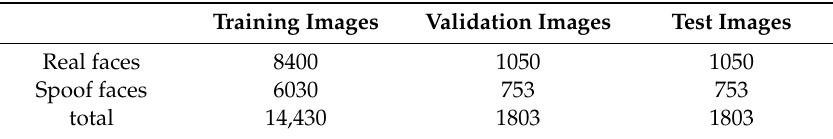
Table 1. Liveness detection dataset, called NenuLD.